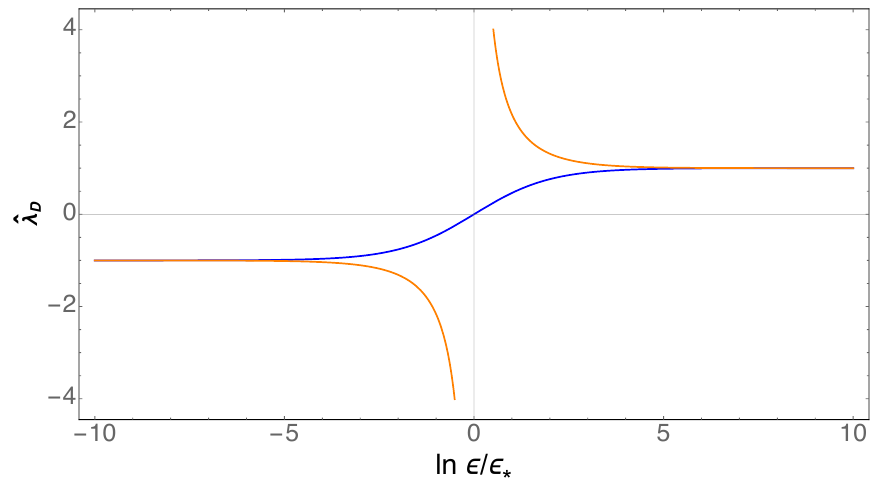
Figure 1 . Plot of the RG (cid:13)ow of ^ (cid:21) (cid:6) (as de(cid:12)ned in the main text) vs ln (cid:15)=(cid:15) ? when Z(cid:11) = 0. A D representative of each of the two RG-invariant classes of (cid:13)ows is shown, and (cid:15) ? is chosen as the place where ^ (cid:21) = 0 or ^ (cid:21) ! 1 , depending on which class of (cid:13)ows is of interest.